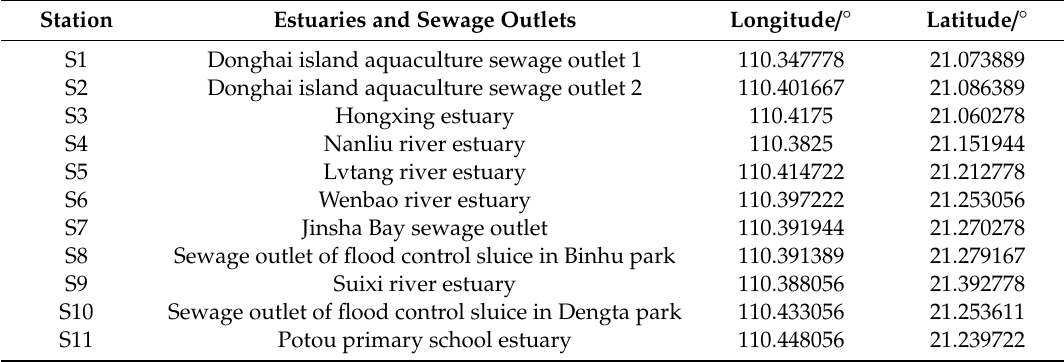
Table 1. Investigation of estuaries and sewage